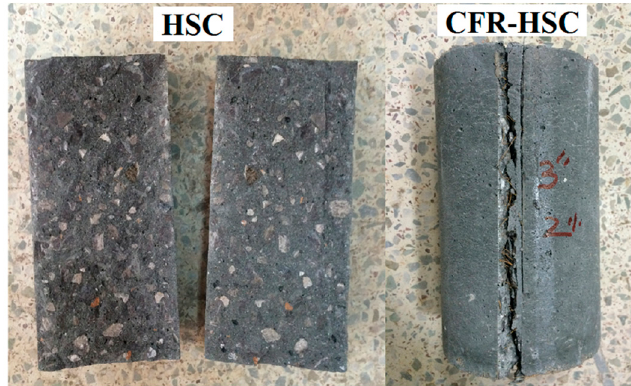
Figure 10. HSC and CFR-HSC specimens after STS test.